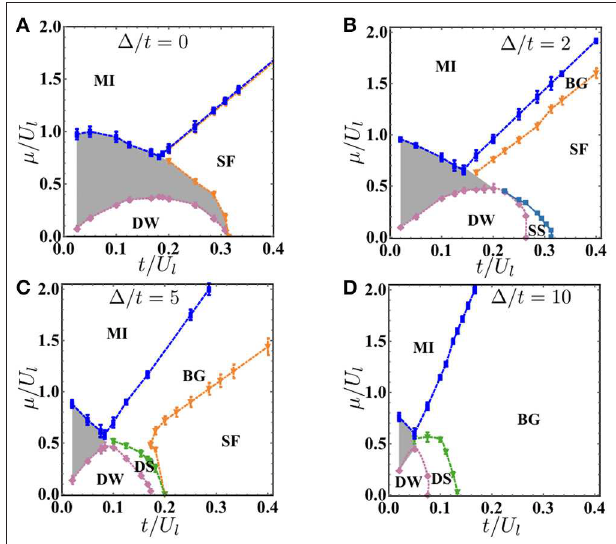
FIGURE 1 | Ground state phase diagrams of model 1 as a function of t / U l and µ/ U l for clean system (A) , and disordered system with disorder strength 1/ t = 2 (B) , 5 (C) , and 10 (D) , respectively. The gray shadowed region is the co-exist region due to first-order phase transition. TABLE 1 | Quantum phases and the corresponding parameters: superfluid stiffness ρ , structure factor S ( π , π ), and compressibility κ . Phase ρ κ S( π , π